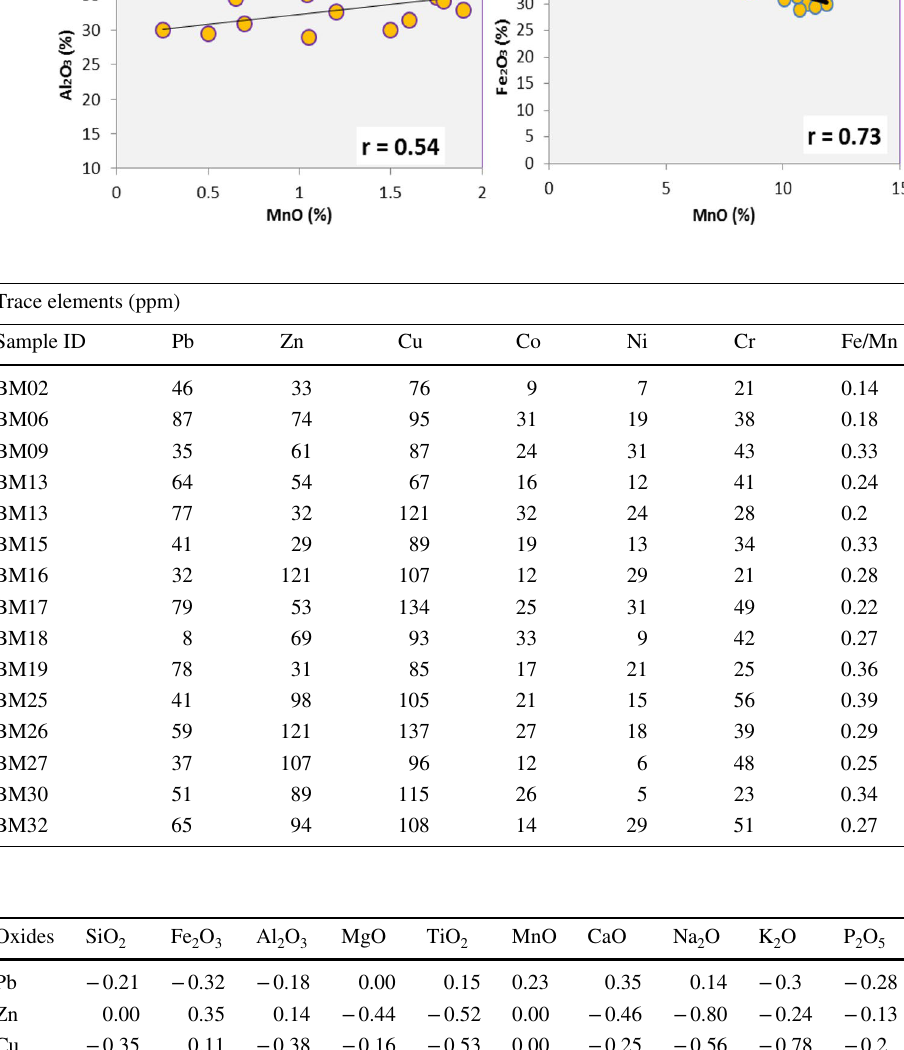
Fig. 4 Selected plots of major oxides showing the correlation between Al 2 O 3 versus MnO and Fe 2 O 3 versus MnO